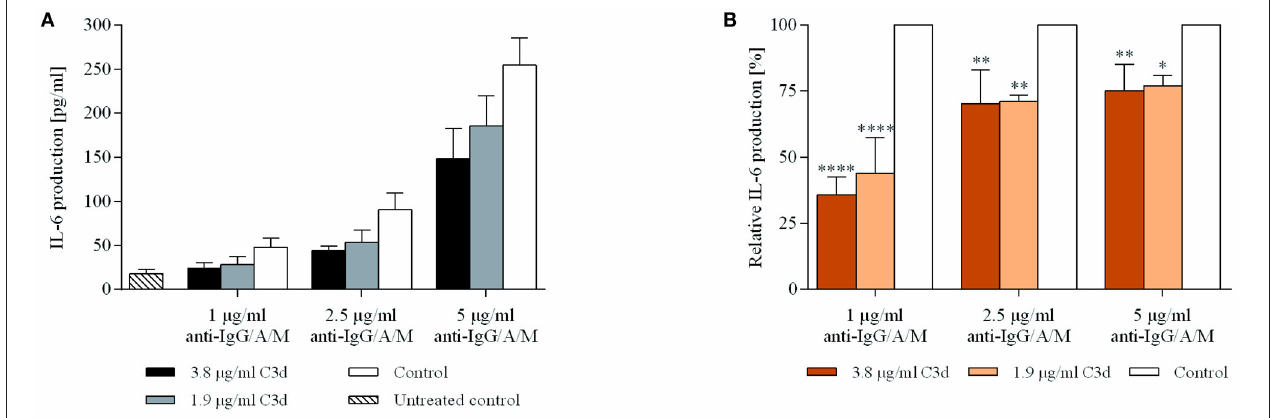
FIGURE 3 | C3d suppresses the BCR induced IL-6 production of human B cells. Resting human B cells were cultured with complexes consisting of either streptavidin-conjugated biotinylated anti-IgG/A/M (control) or streptavidin-linked biotinylated anti-IgG/A/M and biotinylated C3d in different concentrations as indicated. Interleukin (IL)-6 production was measured by ELISA after 48h. Mean IL-6 concentrations ± SD of triplicate samples of a representative donor are shown (A) . Mean IL-6 concentrations of differently treated samples were compared to the control samples taken as 100%. The cumulative results gained in three independent experiments display the mean of the relative values ± SD (B) . * p < 0.05, ** p < 0.01, **** p < 0.0001.